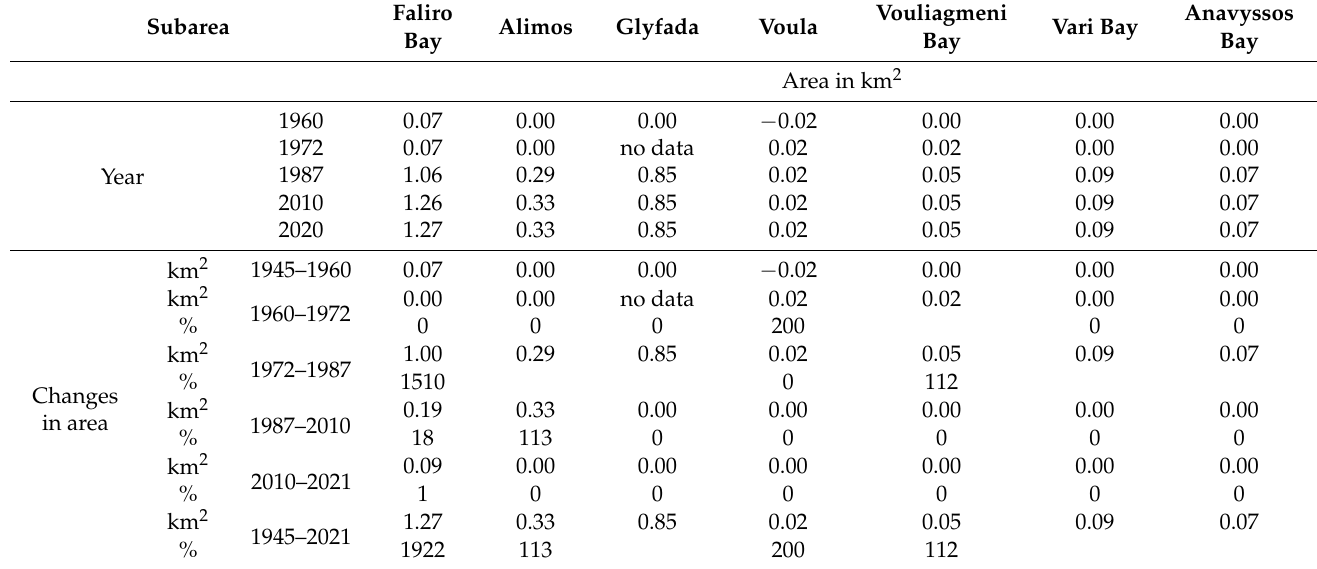
Table 3. The extended areas in each year, the changes in area (in km 2 ) and their percentage (%) between different years for each